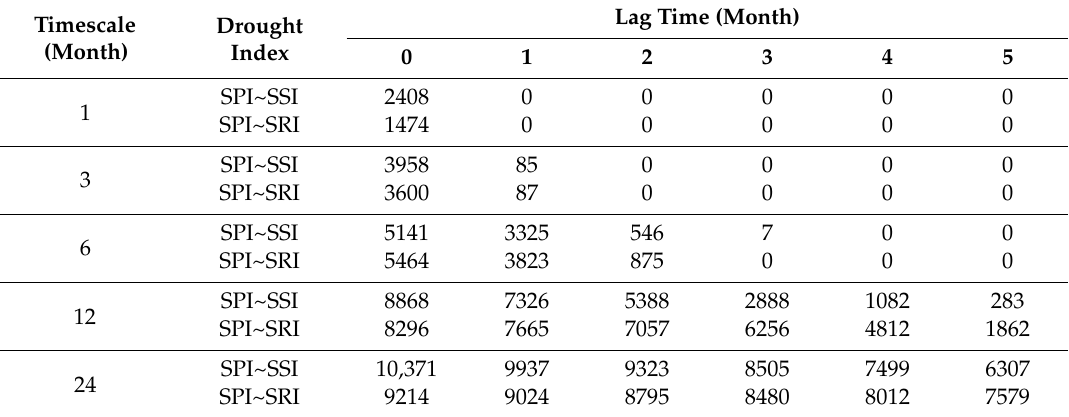
Table 5. The number of grids with r > 0.5 between SPI and SSI or SRI at di ff erent